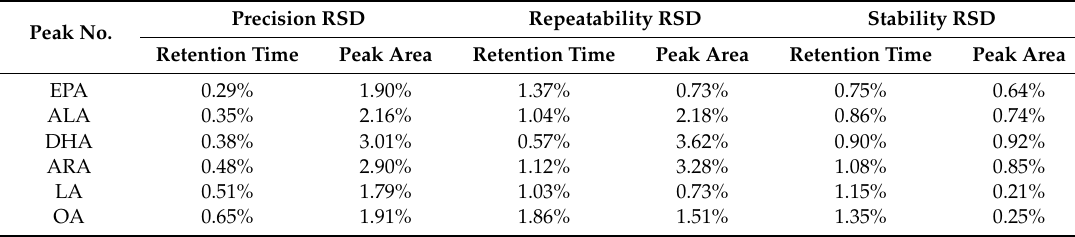
Table 3. The relative standard deviation (RSD) results of methodology validation ( n =